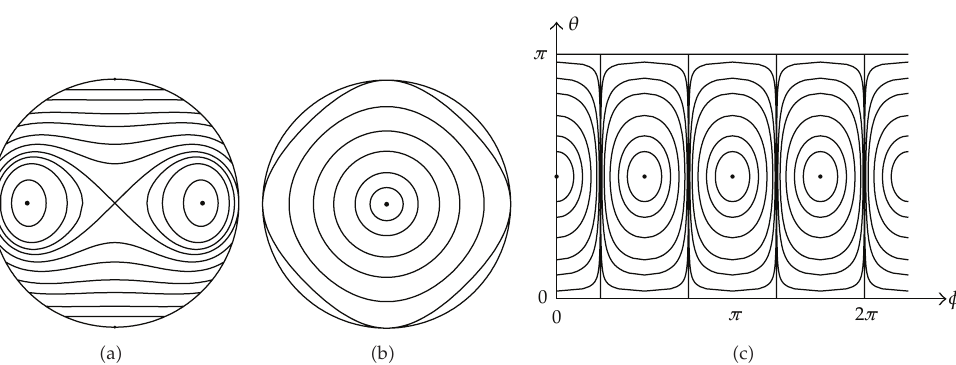
Figure 2: Corotating point vortices on a sphere with m (cid:7) 4 viewed from (cid:5) a (cid:6) positive y -axis; (cid:5) b (cid:6) positive z -axis; (cid:5) c (cid:6) in φ - θ